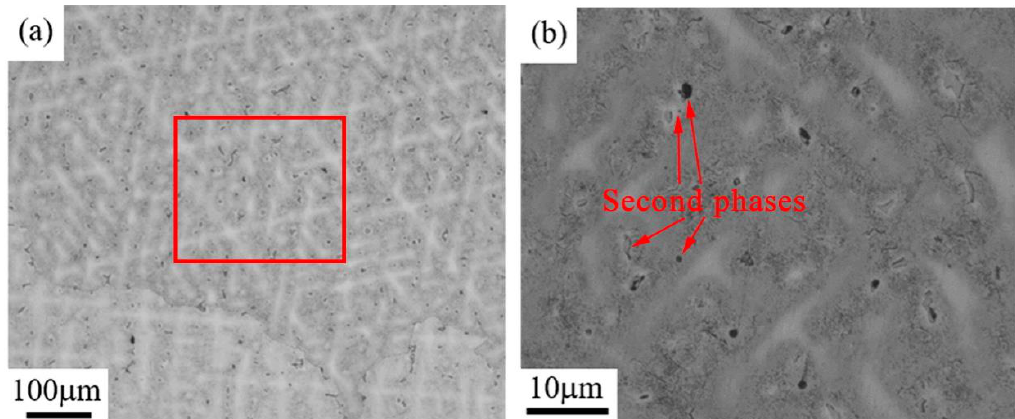
Figure 3. Metallographic images of the as-cast sample of the Cu–6Ni–6Sn–0.6Si alloy: ( a ) low magnification and ( b ) high magnification.